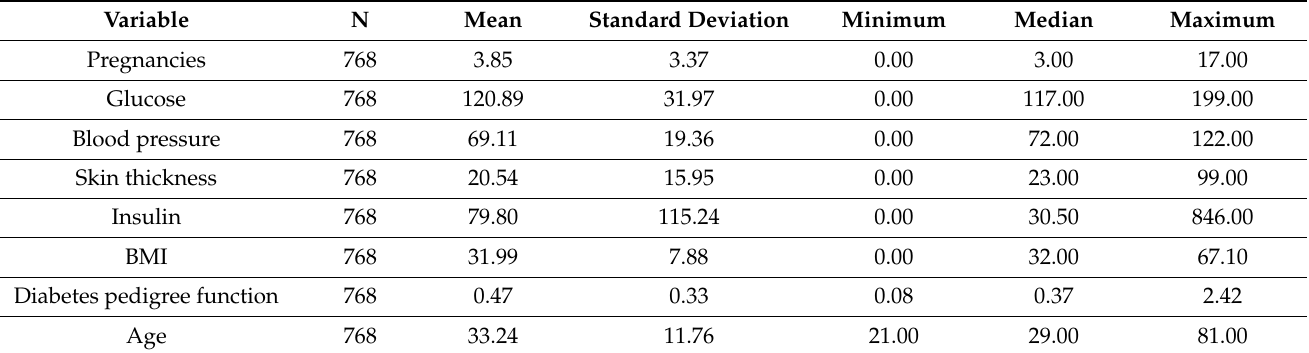
Table 4. Predictors for the diabetes dataset.